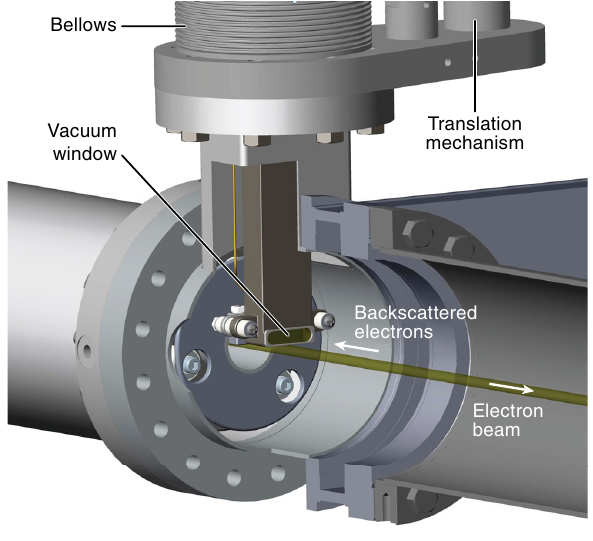
FIG. 6. Cutaway drawing of the detector housing, the vertical translation mechanism and the location of the 0.1 mm thick titanium alloy vacuum window in its lowest position. The area of this window is 25 . 4 × 6 . 35 mm 2 . The vertical position can be changed by up to 25.4 mm away from the electron beam. That highest position was the one used for most measurements to minimize excessive counting-rate issues.